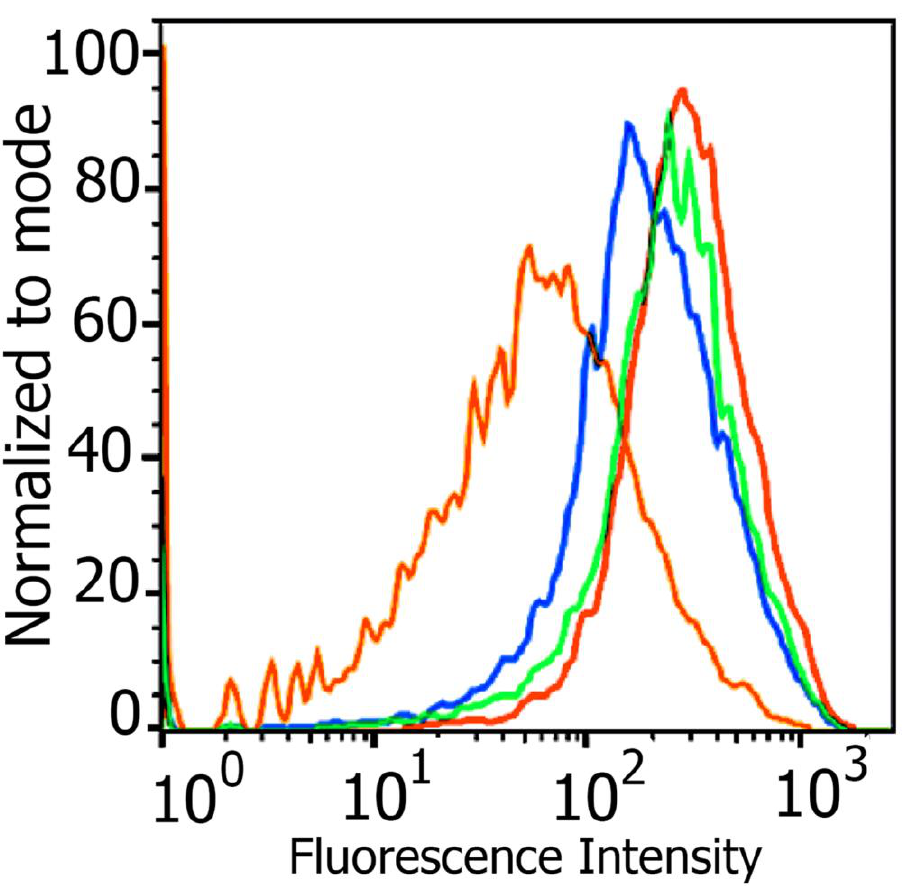
Figure 11. Flow cytometry analysis showing changes in uptake of fibrillar tau under various conditions. Red color represents LRP1-transfected cells treated with fibrillar tau. Green represents LRP1-transfected cells treated with tau fibrils in the presence of angiopep-2 and TauRP1-14 peptide. Blue represents transfected cells treated with fibrillar tau pre-associated with TauRP1-14 peptide. Orange represents untreated non-transfected cells.